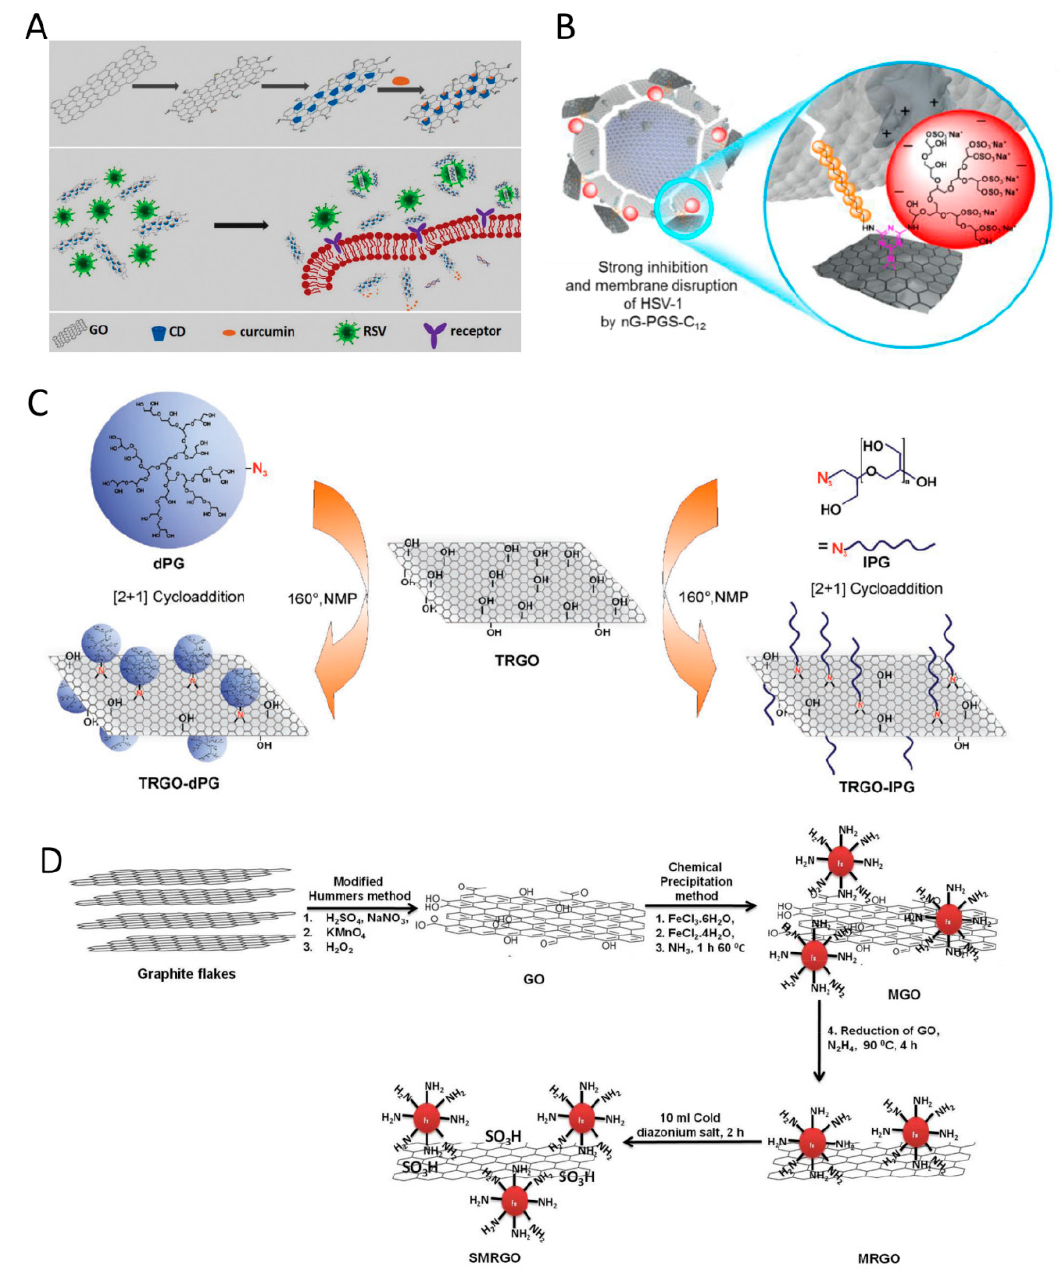
Figure 6. Schematic of various modifications of graphene oxide (GO) for antiviral applications. ( A ) Functionalized GO with cyclodextrin and curcumin to inhibit Respiratory Syncytial Virus (RSV) infection. Reprinted from [163] with permission from the Royal Society of Chemistry; ( B ) Functionalized GO with sulfated groups. Nanographene polyglycerol sulfate coverage enables virus interaction with the positively charged domains of glycoproteins on the surface of Herpes Simplex Virus 1 (HSV-1). Derivatives with long alkyl chain segments ( ≥ C12) show the strongest inhibition and disrupt the virus envelope. Reprinted from [164] with permission from the Royal Society of Chemistry; ( C ) Functionalized reduced GO (rGO) with dendritic polyglycerol (dPG) azide or linear polyglycerol (lPG) azide. Reprinted from [165] with permission from Wiley; ( D ) Functionalization of GO platform with magnetic nanoparticles to produce MRGO. The MRGO is then sulfonated to yield SMRGO. Reprinted from [166] with permission from American Chemical Society.